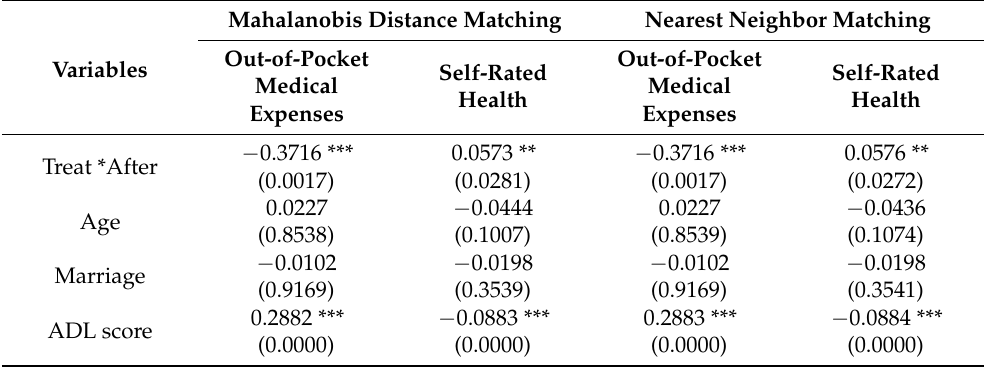
Table 7. Change the PSM matching